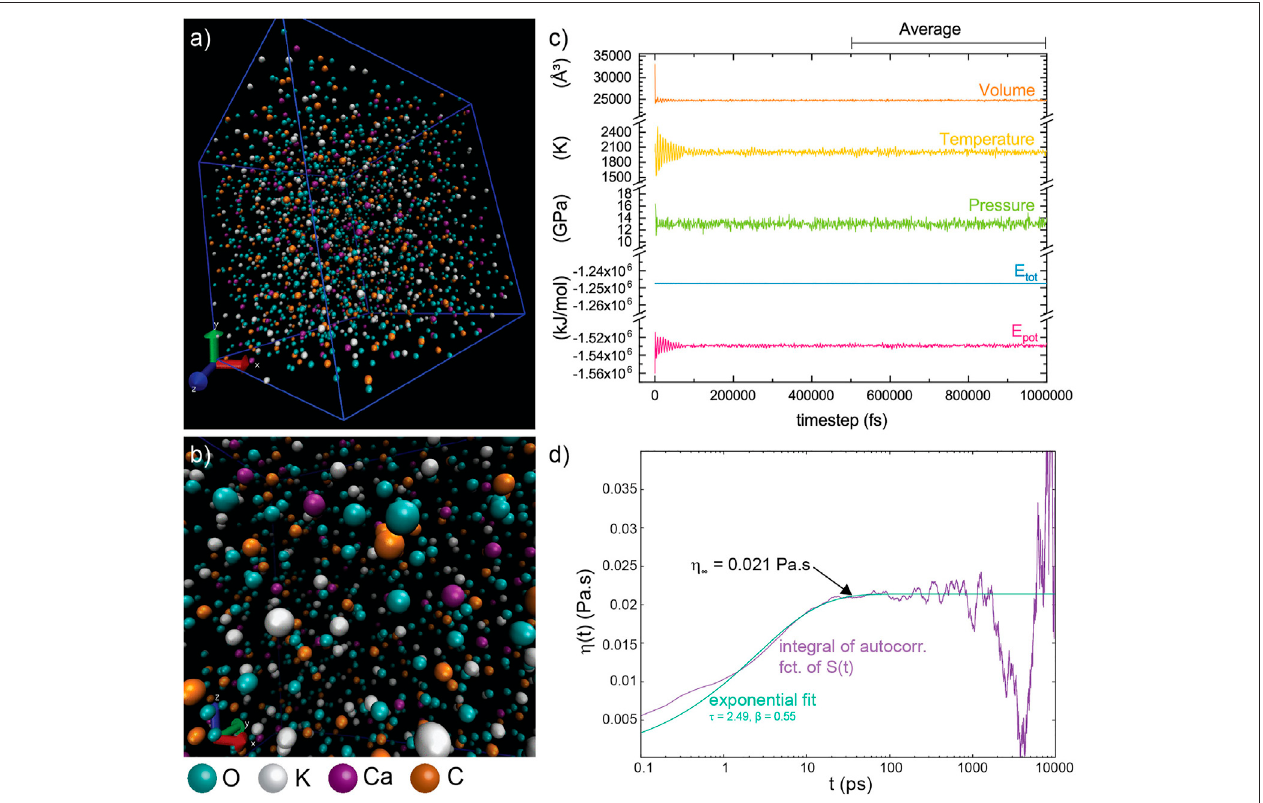
FIGURE1| Classical MD simulation runinK 2 Ca (CO 3 ) 2 melt (KC)at 13 GPaand 2,000 K. (A) – (B) Snapshots ofthesimulationbox containingN (cid:1) 2002atoms. (C) Output of a classical MD simulation from the isothermal-isobaric (NPT) ensemble where the thermodynamic parameters (P, T, V) are calculated from block averages of 500 k time steps, after the system has reached equilibrium. All given uncertainties are the result from statistical fl uctuations, i.e. standard deviation from the average. (D) Integral of the auto-correlation function of the stress tensor S(t) for K 2 Ca(CO 3 ) 2 melt at 3.9 GPa and 1,472 K derived from the MD simulation run in the NVE ensemble (purple line), and corresponding fi t (green line) to an exponential function [ Eq.4 ] to determine the viscosity.